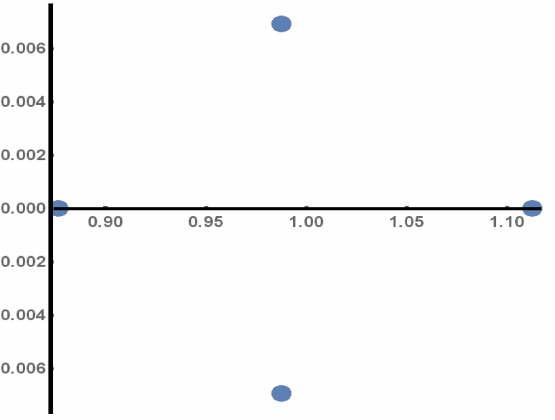
Figure 3. The eigenvalues of the EDMD transition matrix depicted in the complex plane. The above matrix gives rise to a (finite-dimensional) linear dynamical system, whose trajectory (for the specific initial conditions) approximates the real trajectory. The compar- ison between the two trajectories approximated (orange line) and real data (blue line) is shown in Figure 4. Despite the low dimensions of this approximation, the Koopman-EDMD curve approximates well the given data away from the singularity at t = 0 and fails to do so near t = 0. It is possible to considerably improve the approximation by augmenting the dictionary both quantitatively and